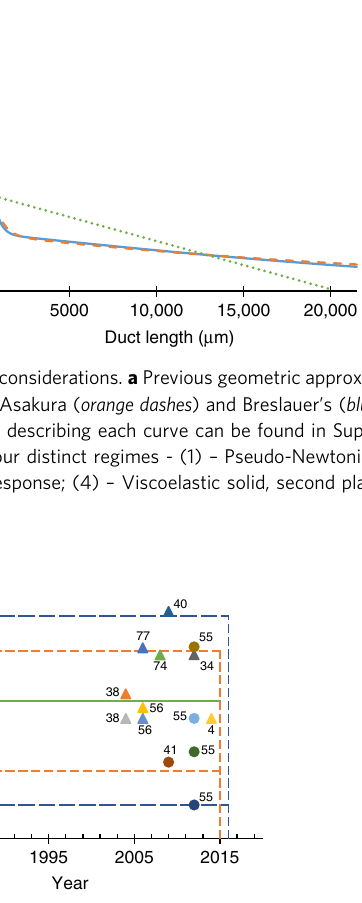
Fig. 4 Biological relevance of previous pressure estimations. A comparison of previous estimations (Kojic (2006), orange plus ; Moriya (2008), yellow circles ; Moriya (2009), green x ; Breslauer (2009), blue triangle ) of the pressure requirements for silk spinning in B. mori silkworms, highlighting the discrepancies between both spinning speed and pressure compared to the natural system. Although the most recent models have aligned spinning speed, the pressure remains too high. The biological extrusion domain is split into natural ( dark green dashes ) and forced ( pale green dashes ) spinning